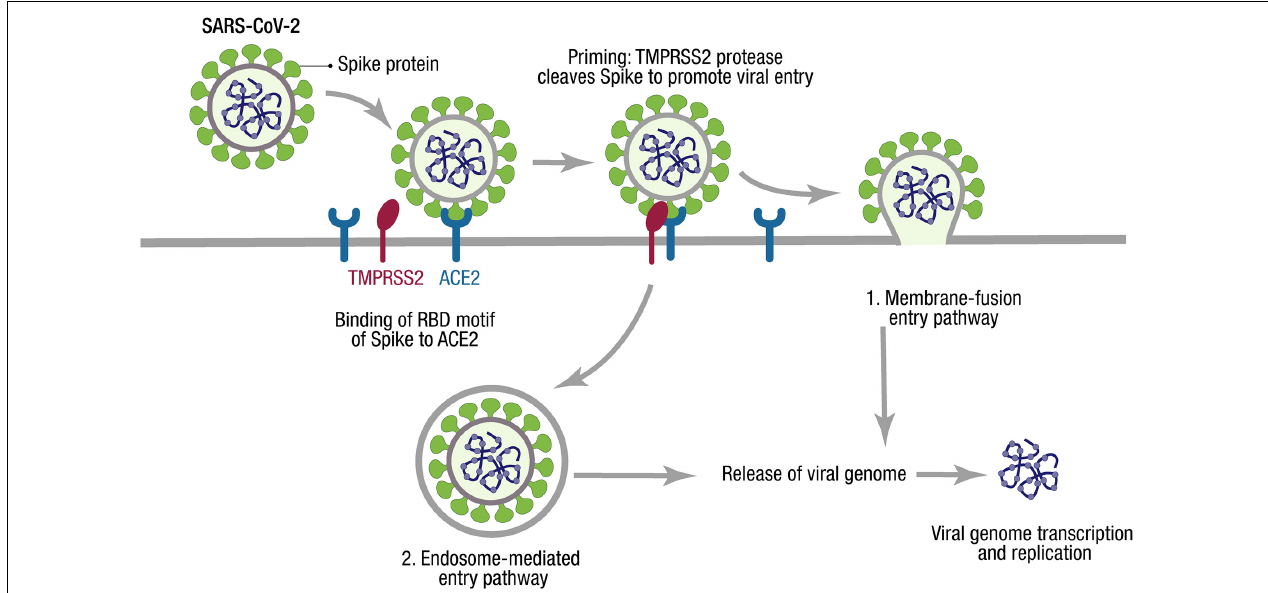
FIGURE 2 | SARS-CoV-2 cell entry mechanism. The SARS-CoV-2 cycle commences by binding the envelope Spike protein to the receptor (ACE2). When recognizing the ACE2 receptor, the RBD stands up to bind the receptor. At the cell membrane, SARS-CoV-2 recruits TMPRSS2, a protease that facilitates viral entry, cleaving S1/S2 site of Spike. Two entry pathways have been described for SARS-CoV-2 cell entry: (1) The presence of proteases triggers the fusion of viral and host membranes. (2) The virus can be endocyted and then released by activation of cathepsin L. Through either entry mechanism, the RNA genome is released into the cytosol, where it is translated and replicated to generate new